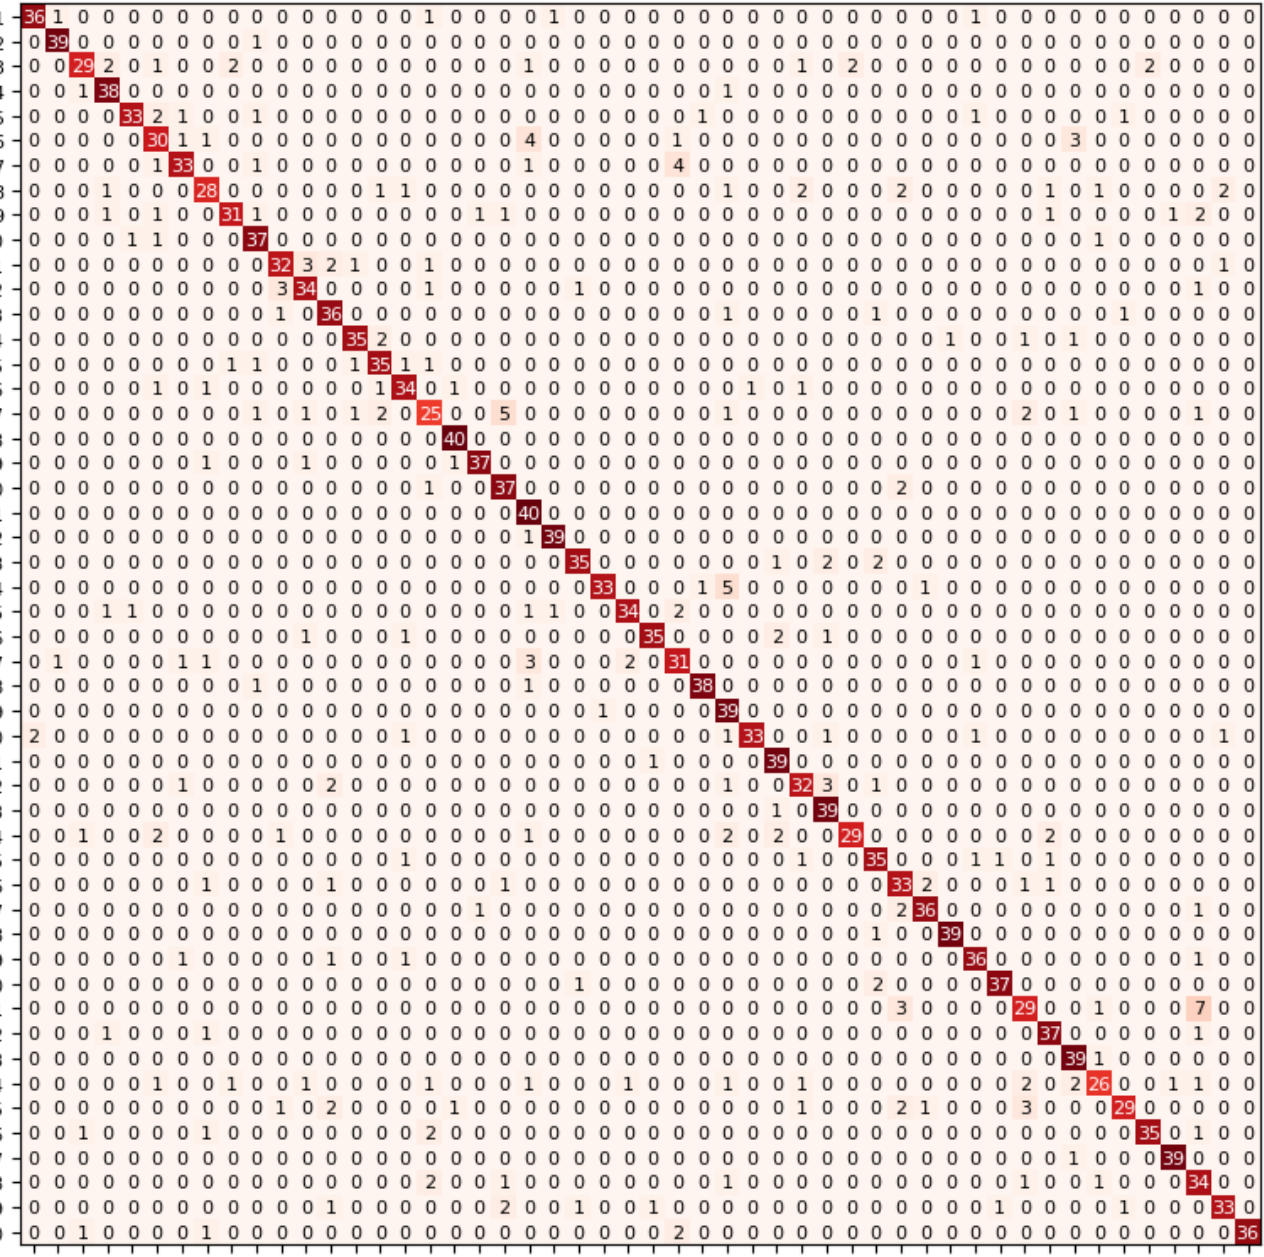
Figure 5. The confusion matrix when the classification accuracy is